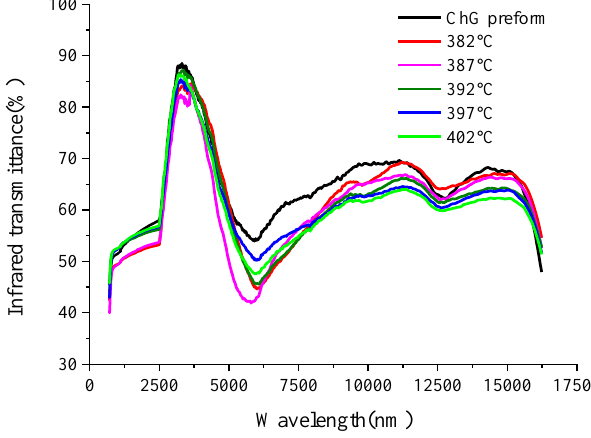
Figure 29. Infrared transmittance of the formed ChG at different molding temperatures.